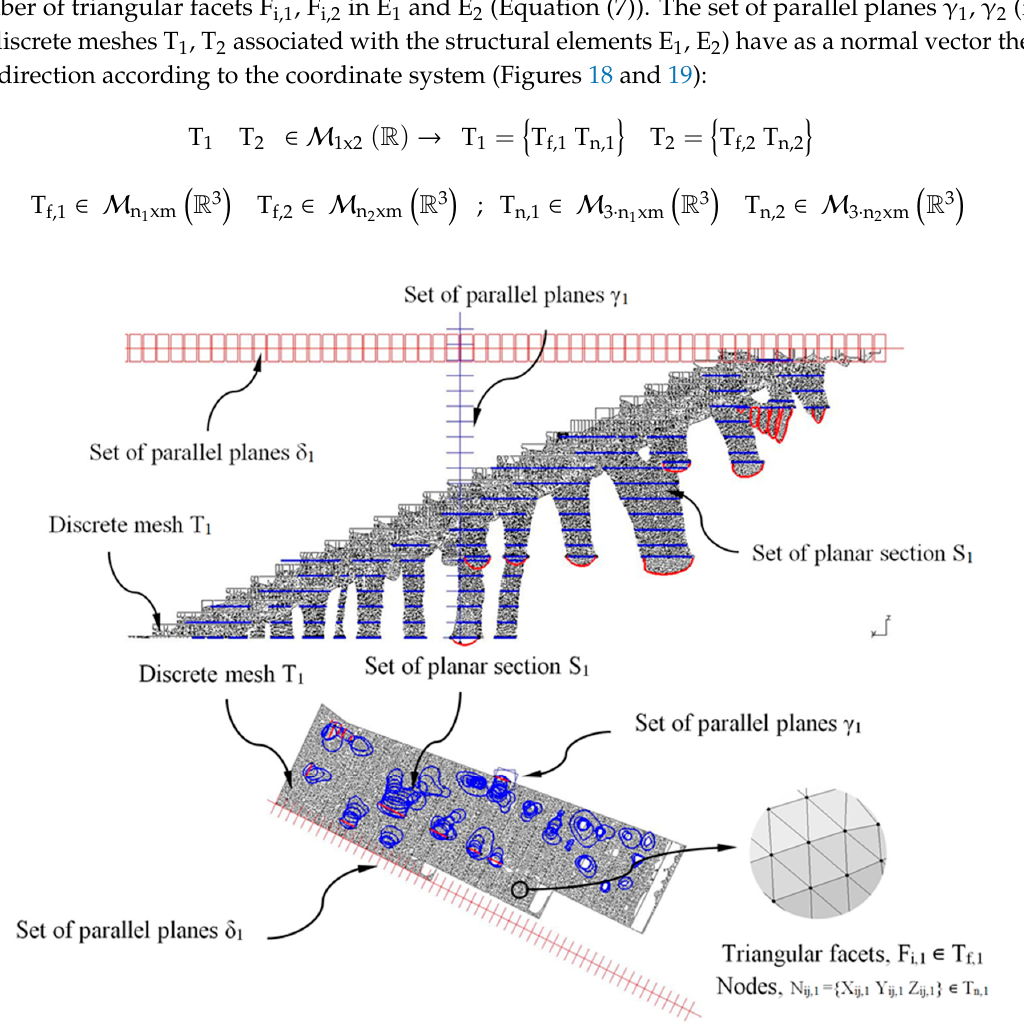
Figure 18. Definition of the sections S 1 generated by the Boolean operation of the intersection